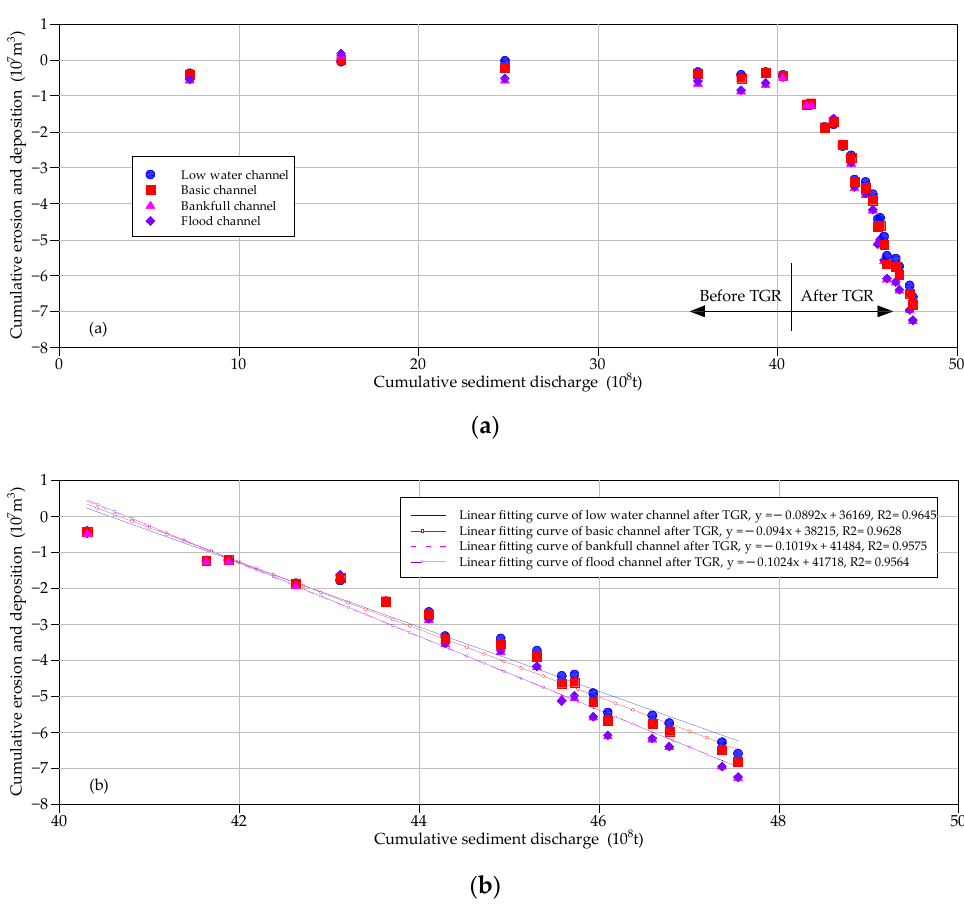
Figure 10. Relationship between cumulative erosion and deposition and cumulative sediment discharge. ( a ) Since 1991; ( b ) After the impoundment of the Three Gorges Reservoir.